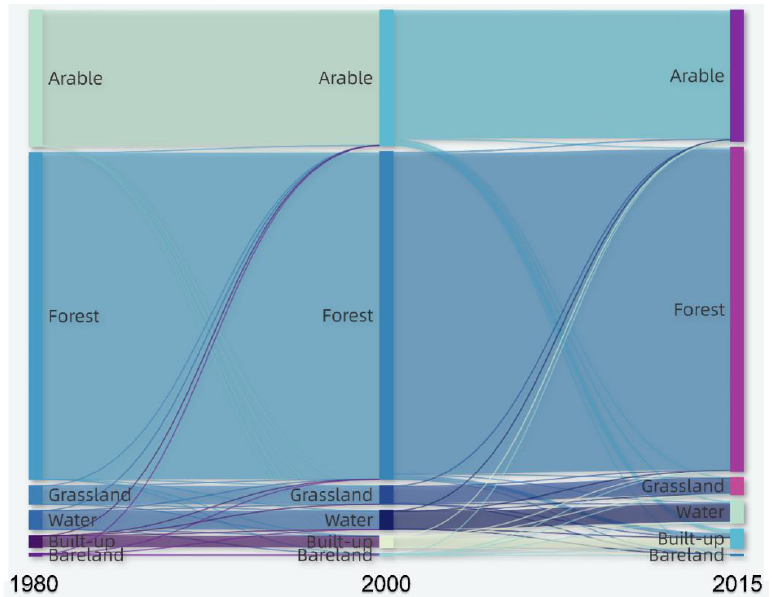
Figure 4. Distribution and long time series area of ecosystem types on Hainan Island from 1980 to 2015.